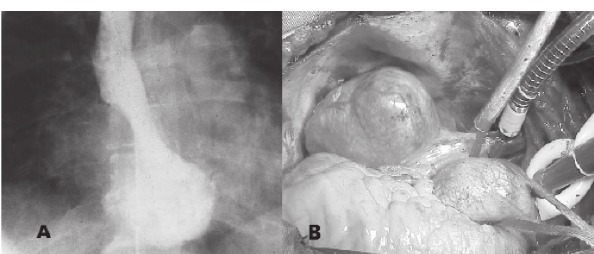
Figure 1 - A. Angiography showing right atrial mass. B. Surgical appearance of the tumor.